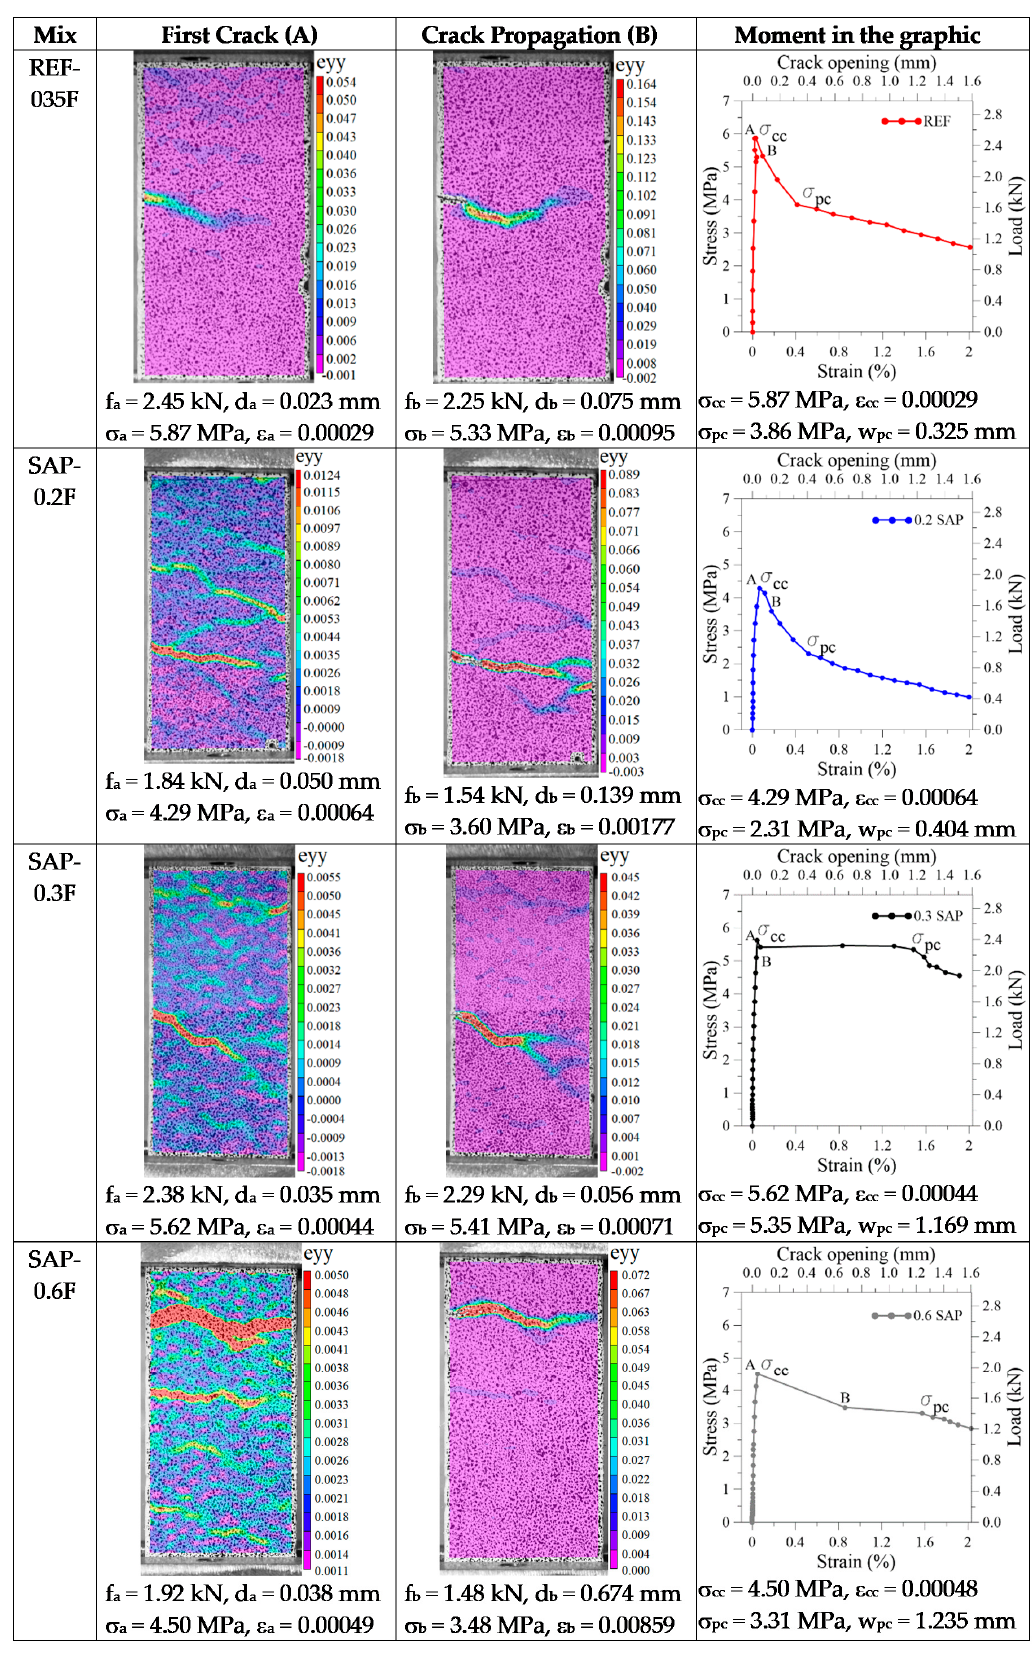
Figure 8. Morphology of cracking apparent on the face of a specimen of SFRC, where A is the first cracking point, and B is the crack propagation, both presented in the respective graphic for each